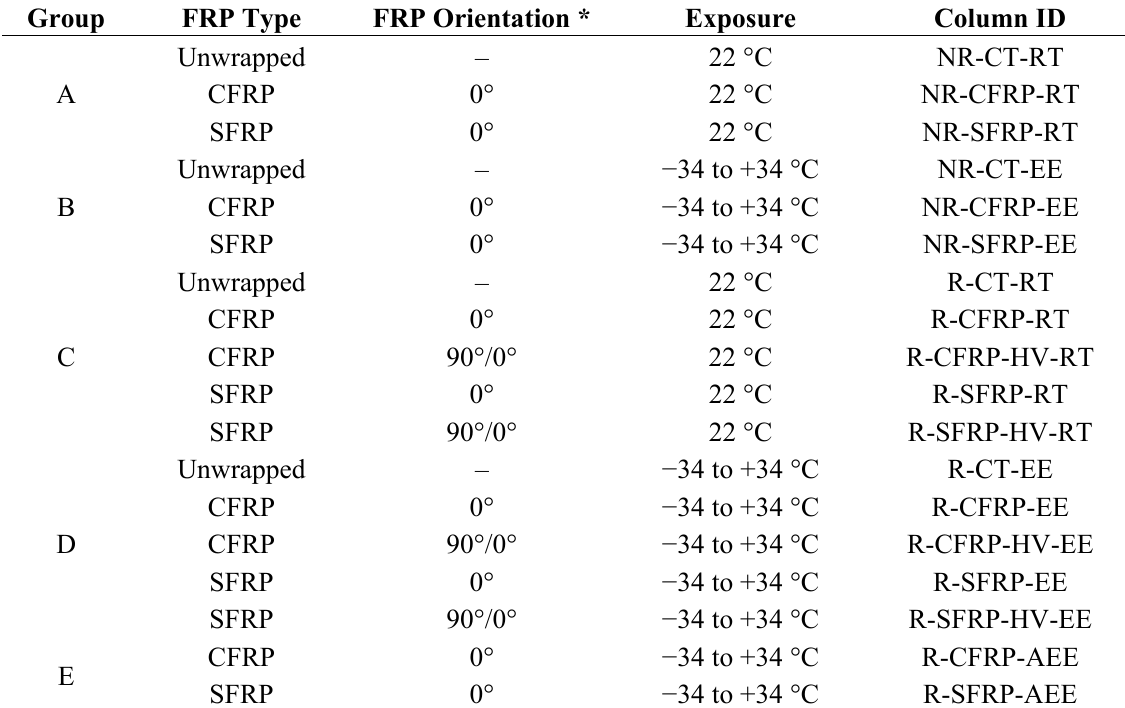
Table 1. Test matrix of the large-scale columns wrapped with CFRP and SFRP sheets, with their respective control